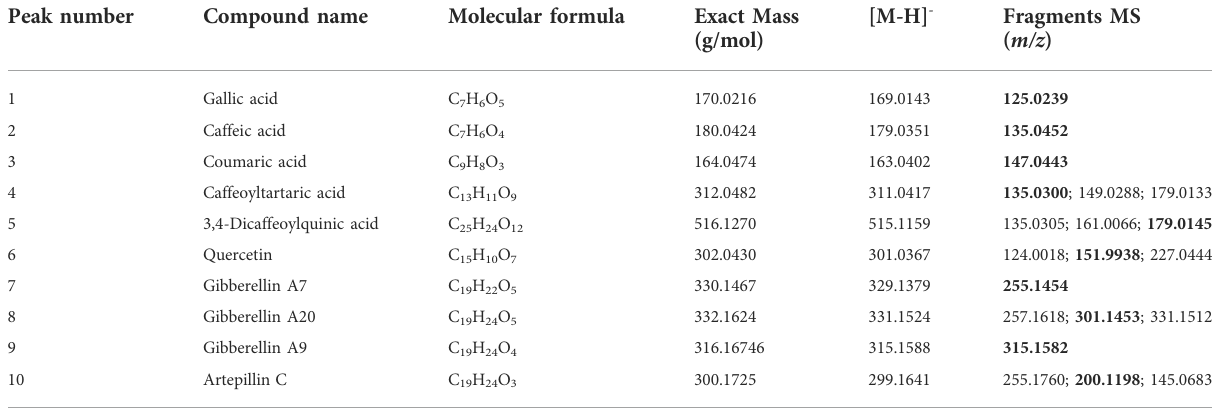
TABLE 2 Phytochemical pro fi le by LC-ESI-QTOF-MS of Brazilian Organic Propolis mix. Peak